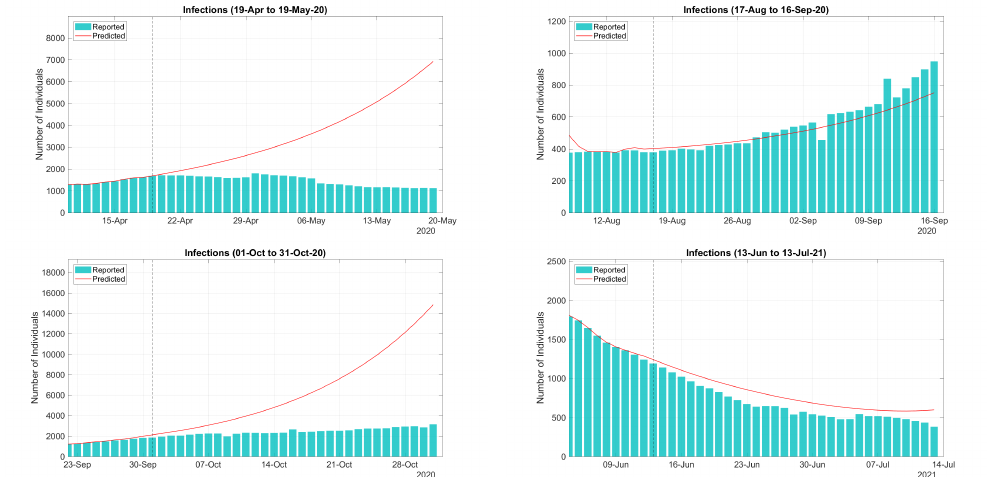
Figure 5. Comparison between the 7-day moving average of daily reports (blue bars) of COVID-19 infections and the 30-day ahead model predictions (solid lines) for Canada. The dashed line separates the calibration dataset from the prediction/testing